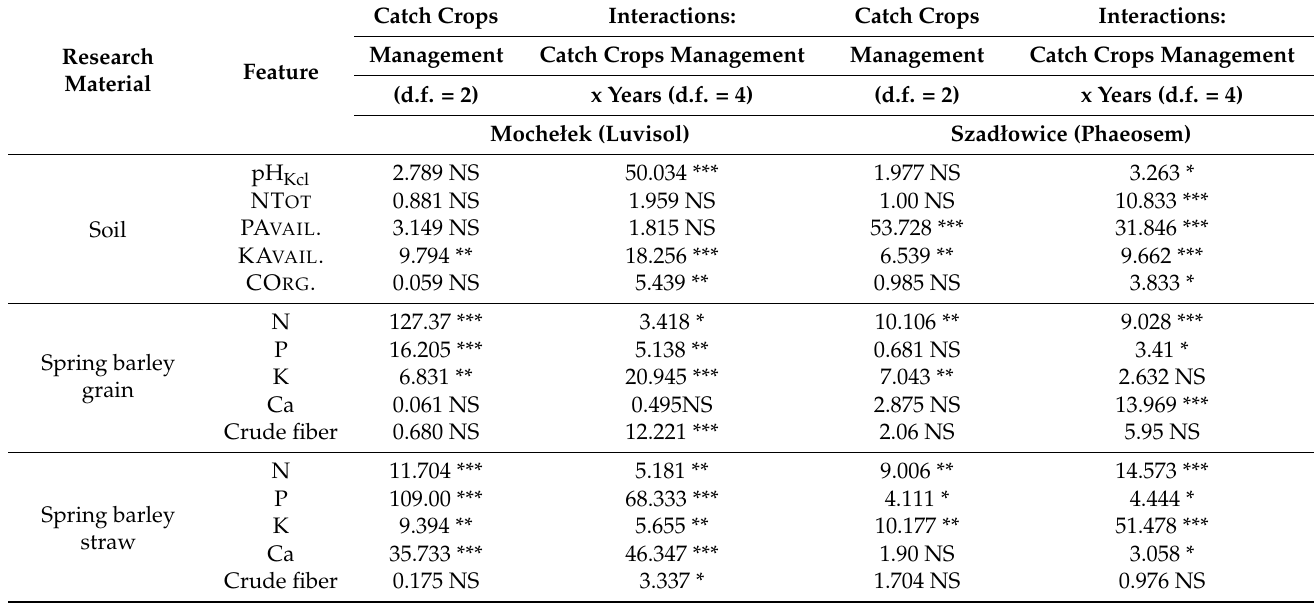
Table 3. Statistical differences (F-values and significance level) between means of variables by one-way ANOVA with factor catch crops management (d.f. =